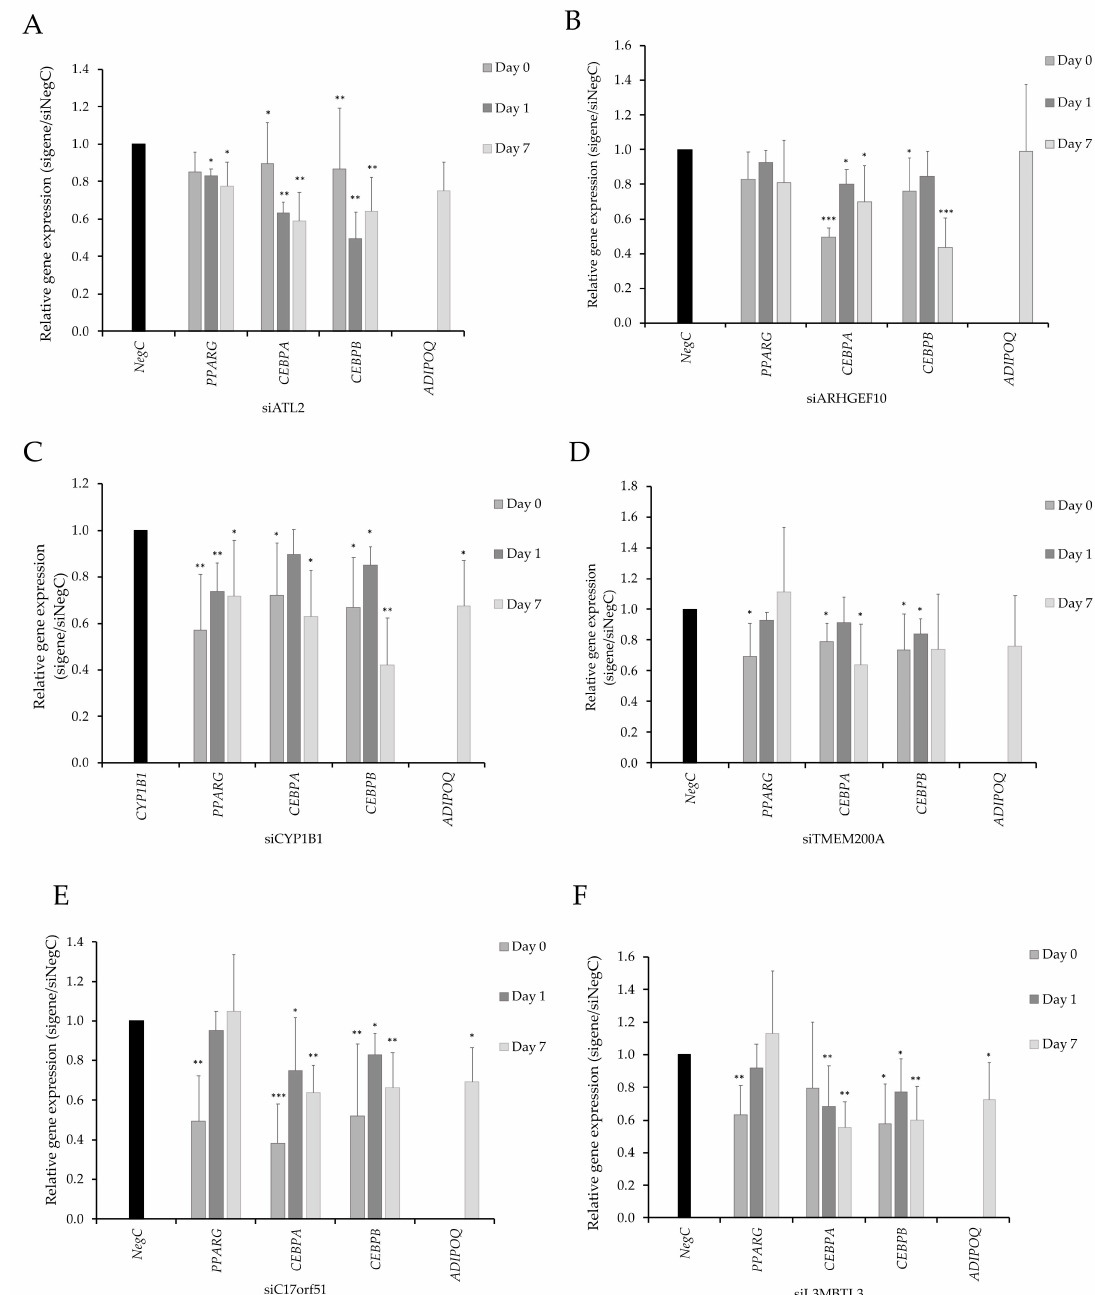
Figure 5. ( A–F ) The expression of peroxisome proliferator-activated receptor-gamma ( PPARG ), CCAAT / enhancer-binding protein alpha ( CEBPA ), and CCAAT / enhancer-binding protein beta ( CEBPB ) measured on day 0, 1, and 7. The expression of ADIPOQ was only measured at day 7. Results are based on three biological / independent experiments. Expression of genes was normalized to the reference gene 18s. Results were analyzed using a t -test and presented in fold change ± SD relative to negative control of a corresponding time point (Neg C). *** p < 0.005, ** p < 0.01, * p <